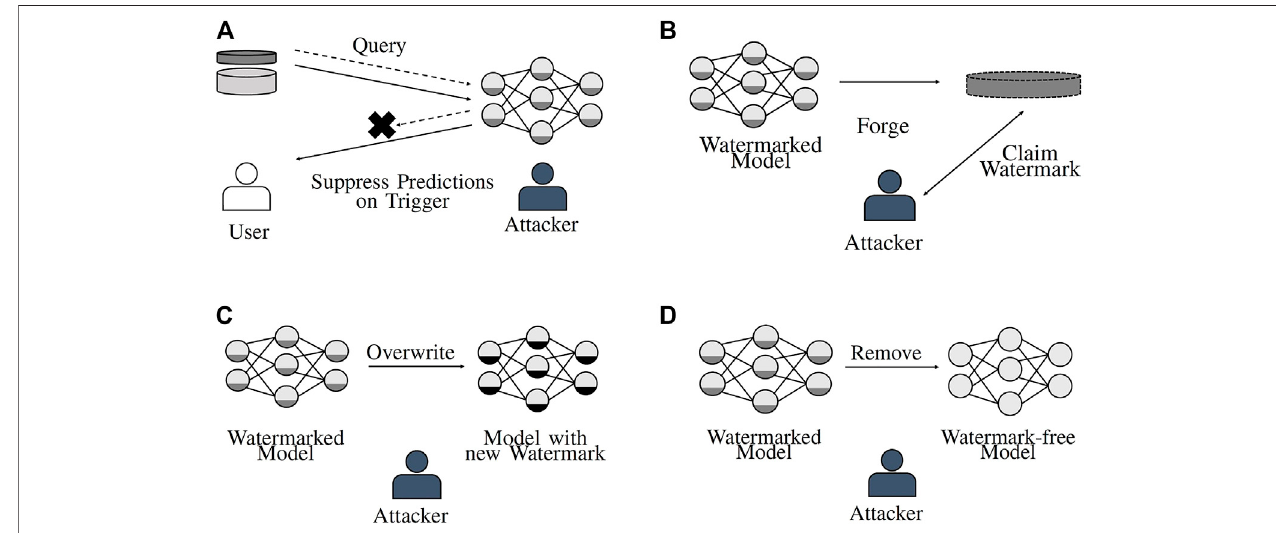
FIGURE6| Methodsanattackercanapplytopreventthedetectionofawatermarkinastolenmodel. (A) Suppresswatermark. (B) Forgewatermark. (C) Overwrite watermark. (D) Remove watermark.